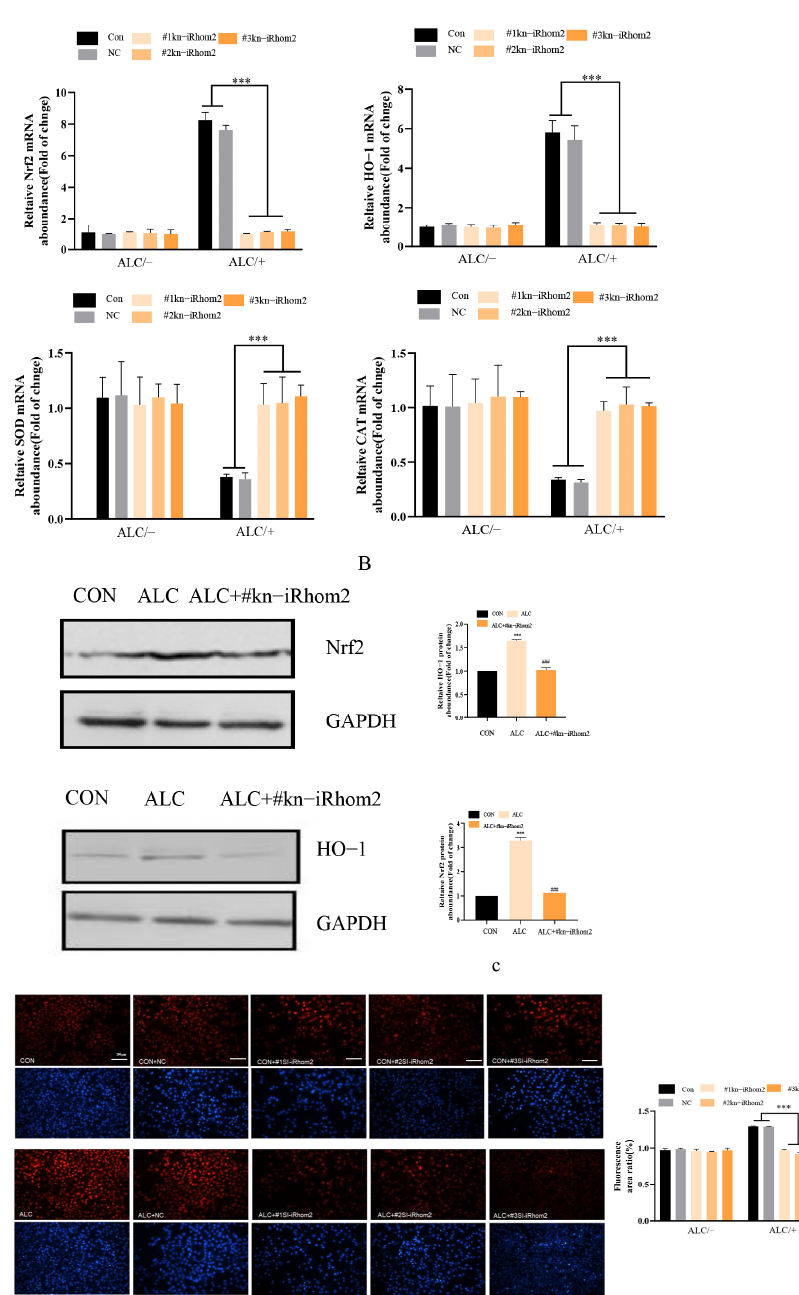
Figure 5. The iRhom2 knockout reduced alcohol-induced oxidative stress and JNK activation in L02 cells; ( A ) The mRNA expression of L02 cells containing a blank vector after the administration of alcohol induction (NC) or the knockout of iRhom2 (kn-iRhom2) was analyzed with the qPCR method to calculate the levels of cellular oxidative stress in HO-1, Nrf2, CAT, and SOD; ( B ) WB analysis of HO-1 and Nrf2 in L02 cells; ( C ) assessment of the total ROS levels in L02 cells. The data are expressed as the mean ± SD ( n = 6). *** p < 0.001 vs. the NC and control group; ### p < 0.001 vs. the ALC group.